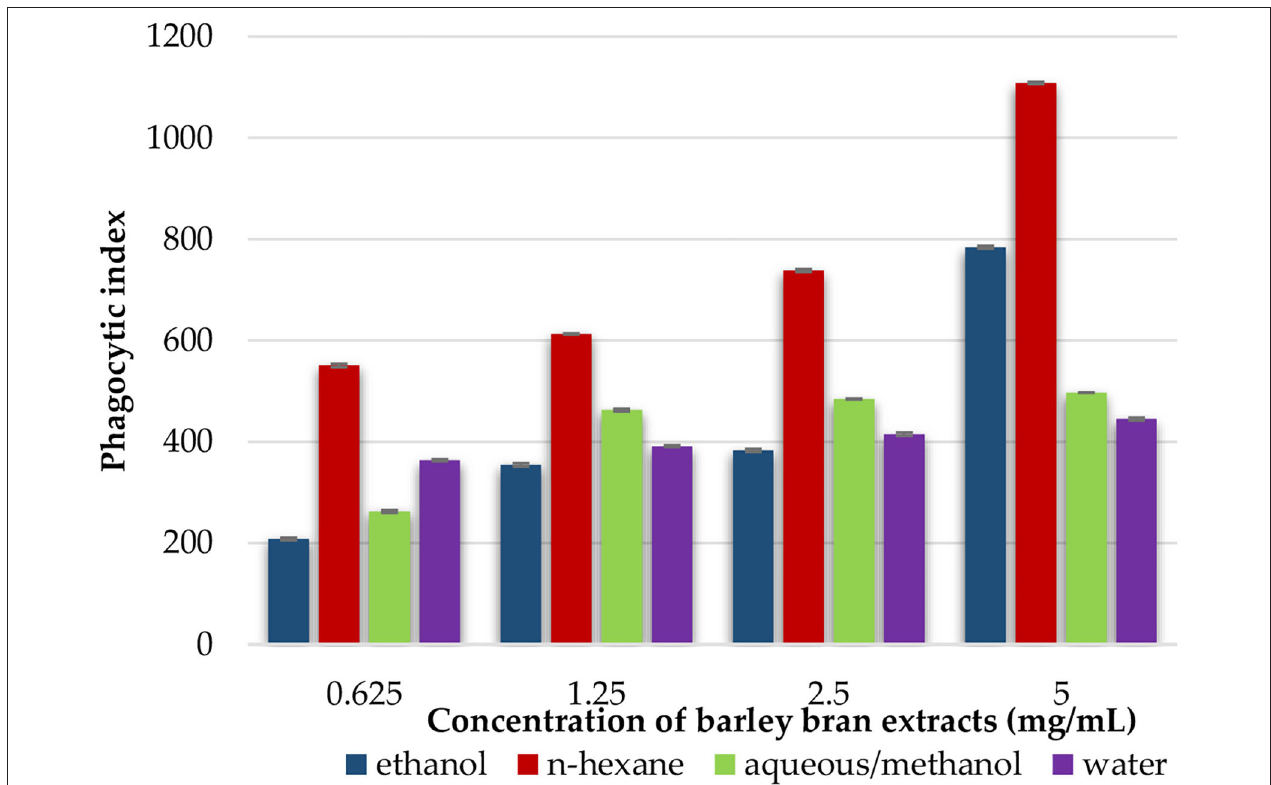
FIGURE 4 | An in vitro phagocytic assay using nitro blue tetrazolium (NBT) reduction test of peritoneal macrophage treated with various concentrations of barley bran extracts for